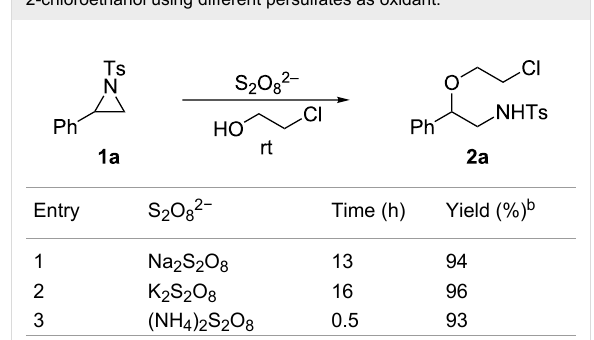
efficient method for the synthesis of 2-substituted and 2,3- disubstituted morpholines from aziridines utilizing a simple and inexpensive ammonium persulfate salt as the oxidant at room temperature (Scheme 1b) [32,33].